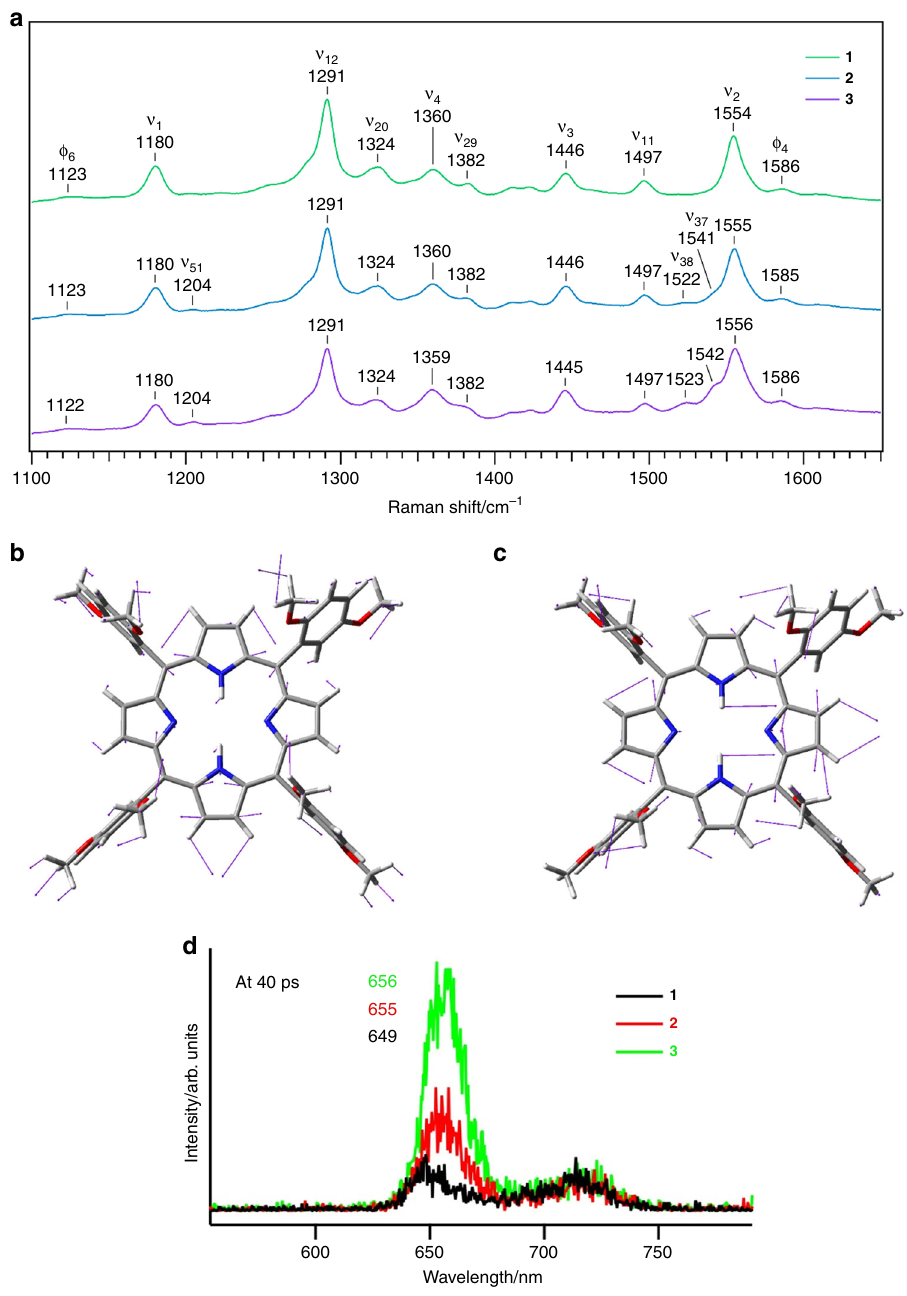
Fig. 4 Experimental evidence of subtle porphyrin ring distortion. a Resonance Raman spectra for compounds 1 ‒ 3 in the high frequency region recorded by exciting at 405 nm in dichloromethane at room temperature. With increasing chain lengths, the three bands centred at 1204, 1522 – 1523, and 1541 – 1542 cm – 1 become prominent. b , c Eigenvectors calculated for the two E u modes ν 37 at 1535 cm – 1 ( b ) and ν 38 at 1545 cm – 1 ( c ). These modes are associated with out-of-plane stretching of porphyrin ring. d Time-resolved fl uorescence spectra of compounds 1 ‒ 3 collected at 40 ps of excitation, measured in toluene by exciting at 400